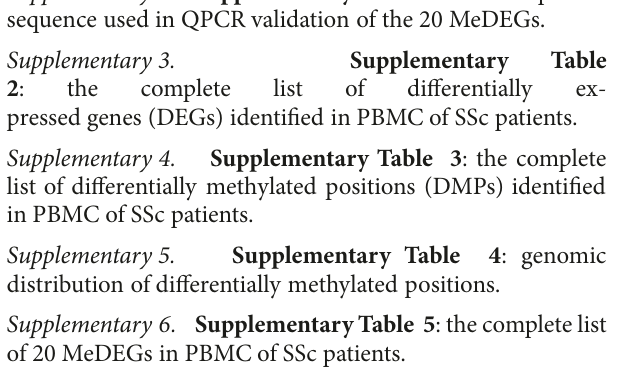
2 : GO analysis of the downregulated genes (left) and upregulated genes (right) in PBMC from SSc patients as compared to normal controls. Statistically significant GO terms are shown. S upplementary Figure 3 : GO analysis of the hypomethylated genes (left) and hypermethylated genes (right) in PBMC from SSc patients as compared to normal controls. Statistically significant GO terms are shown. Supplementary 2. S upplementary Table 1 : the list of primer sequence used in QPCR validation of the 20